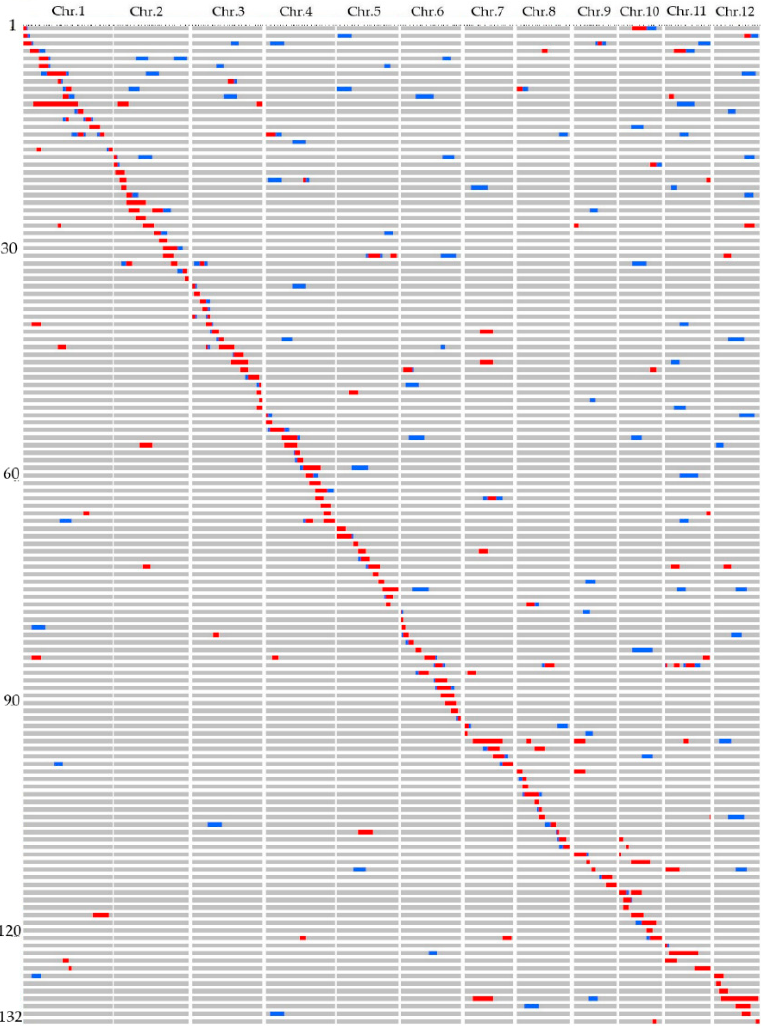
Figure 3. Graphic genotypes of the 132 DP30-CSSLs developed in this study. Red bars indicate